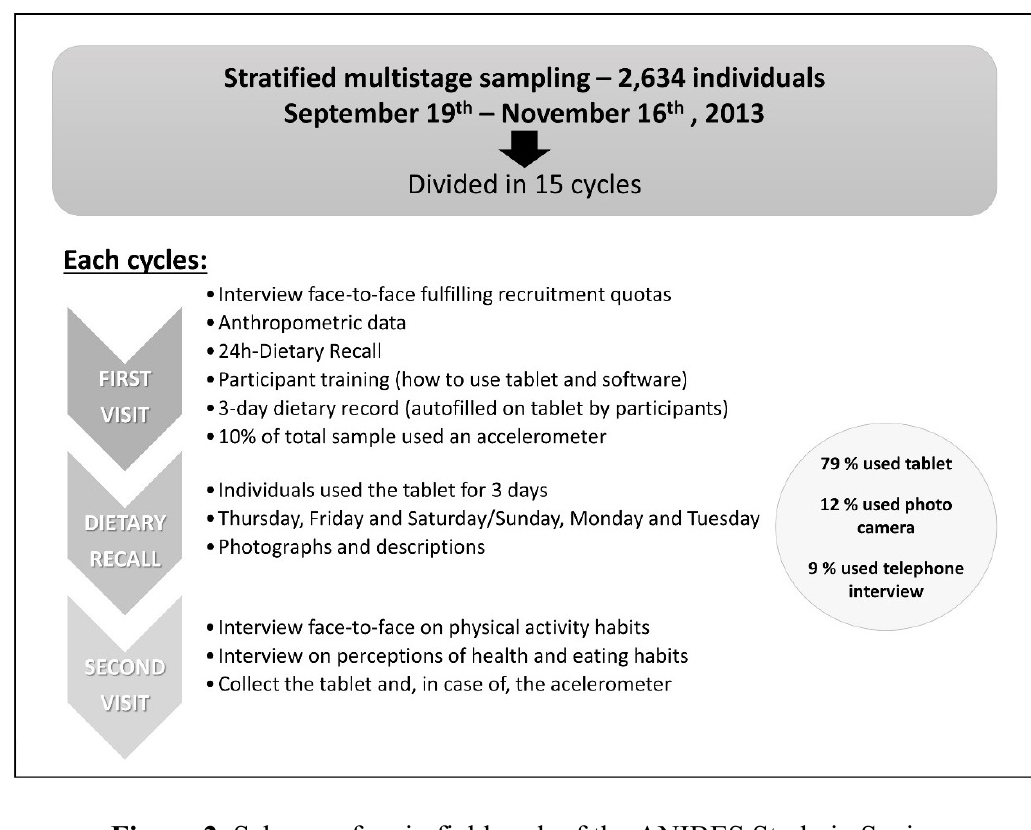
Figure 2. Scheme of main fieldwork of the ANIBES Study in